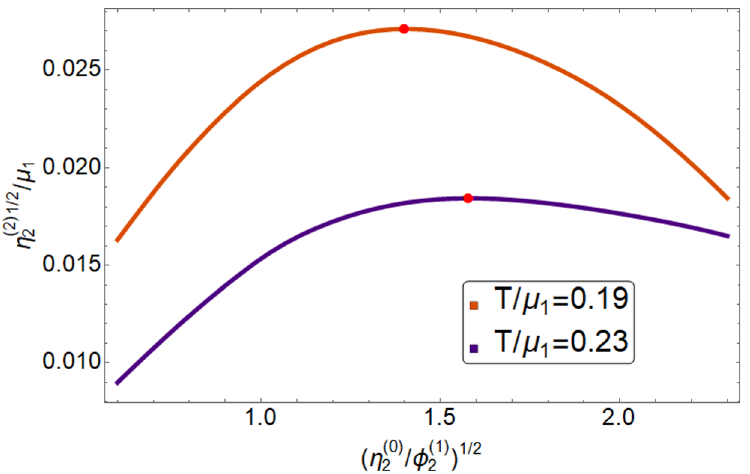
Figure 15 . The relation between the PDW order parameter η (2) parameter to the CDW order parameter η (0)